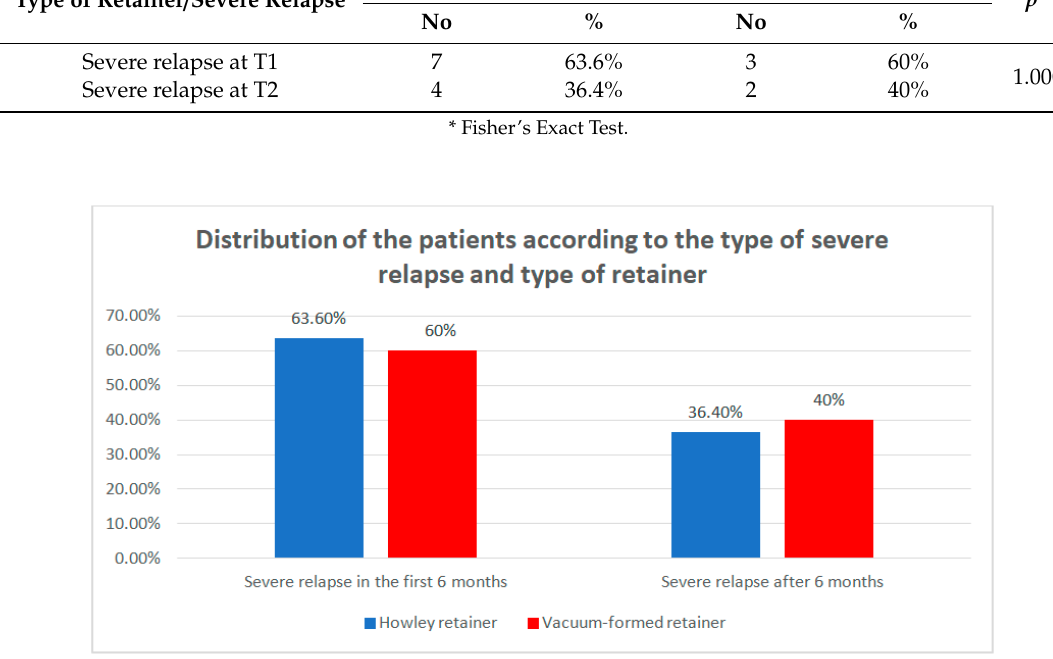
Figure 12. Distribution of the patients according to the type of severe relapse and type of retainer.